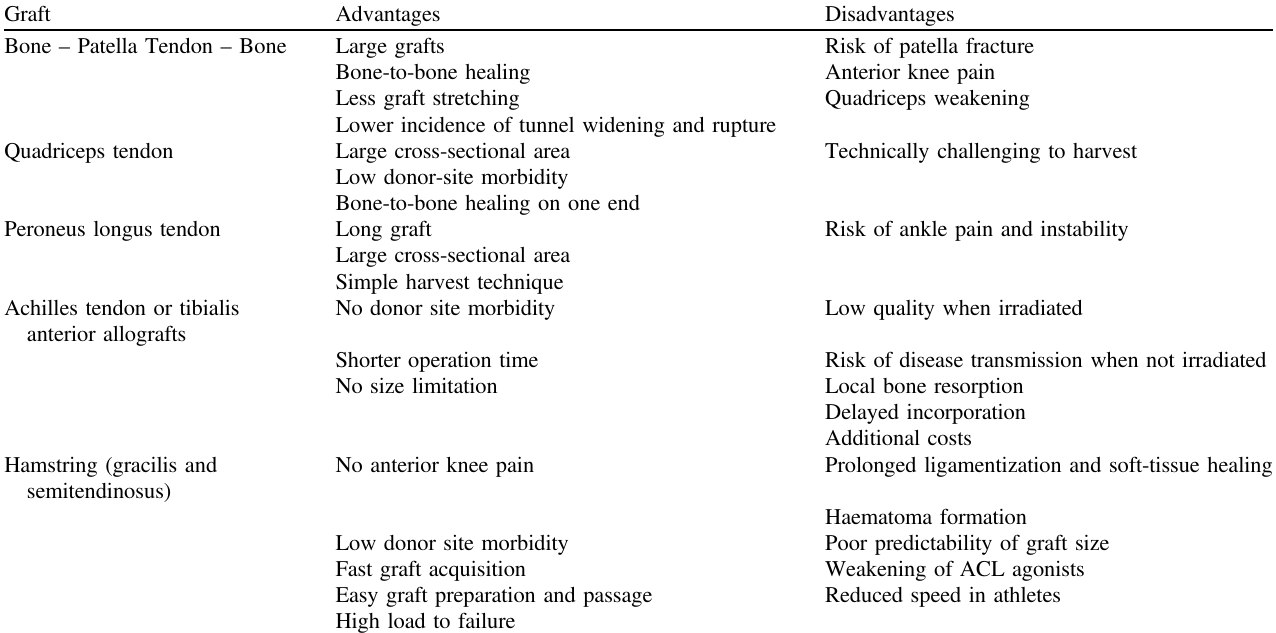
Table 4. Advantages and disadvantages of different grafts [64, 65]. Graft